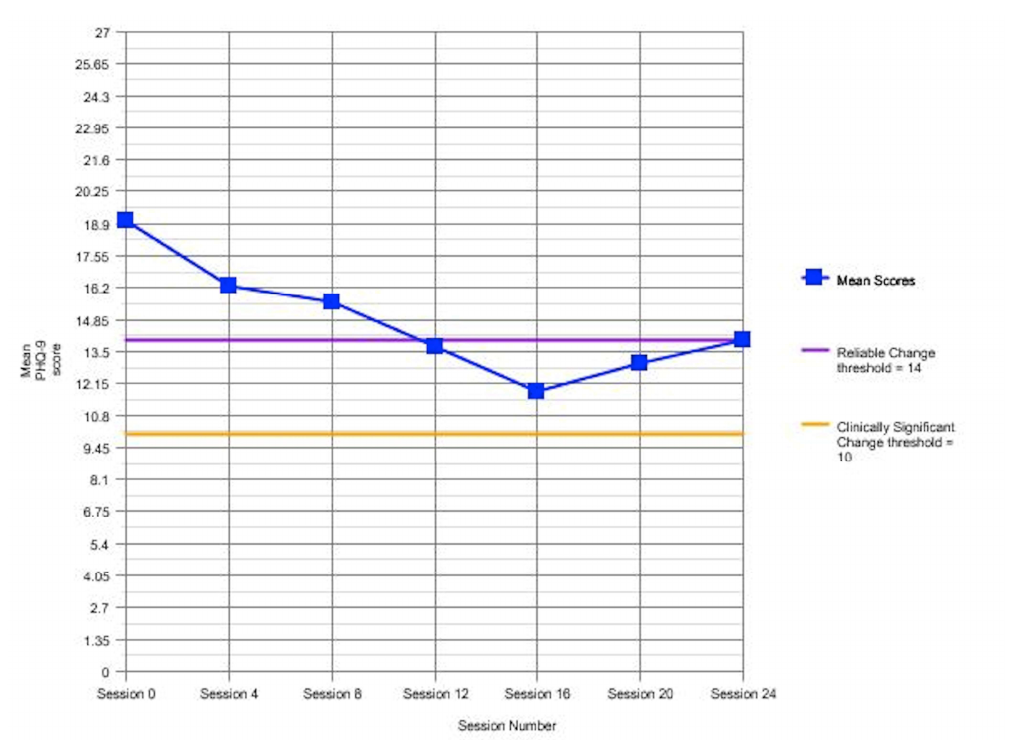
Figure 5: Mean PHQ-9 score: 7 short-term